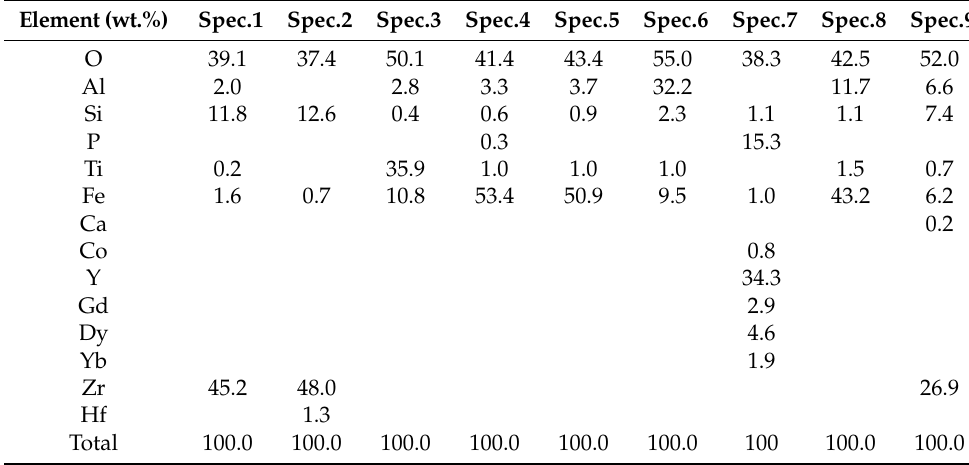
Table 5. Results of chemical analysis of points (sample 099, Figure 9). Element